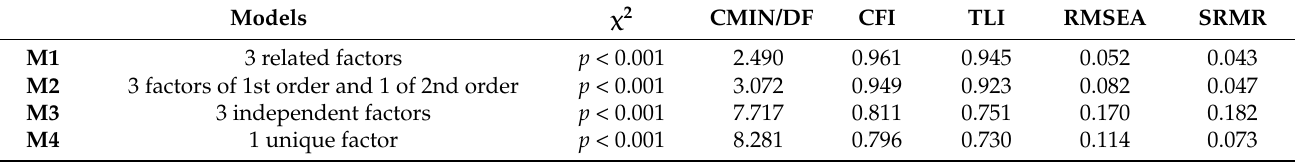
Table 3. Goodness-of-fit indices of the proposed academic success attribution